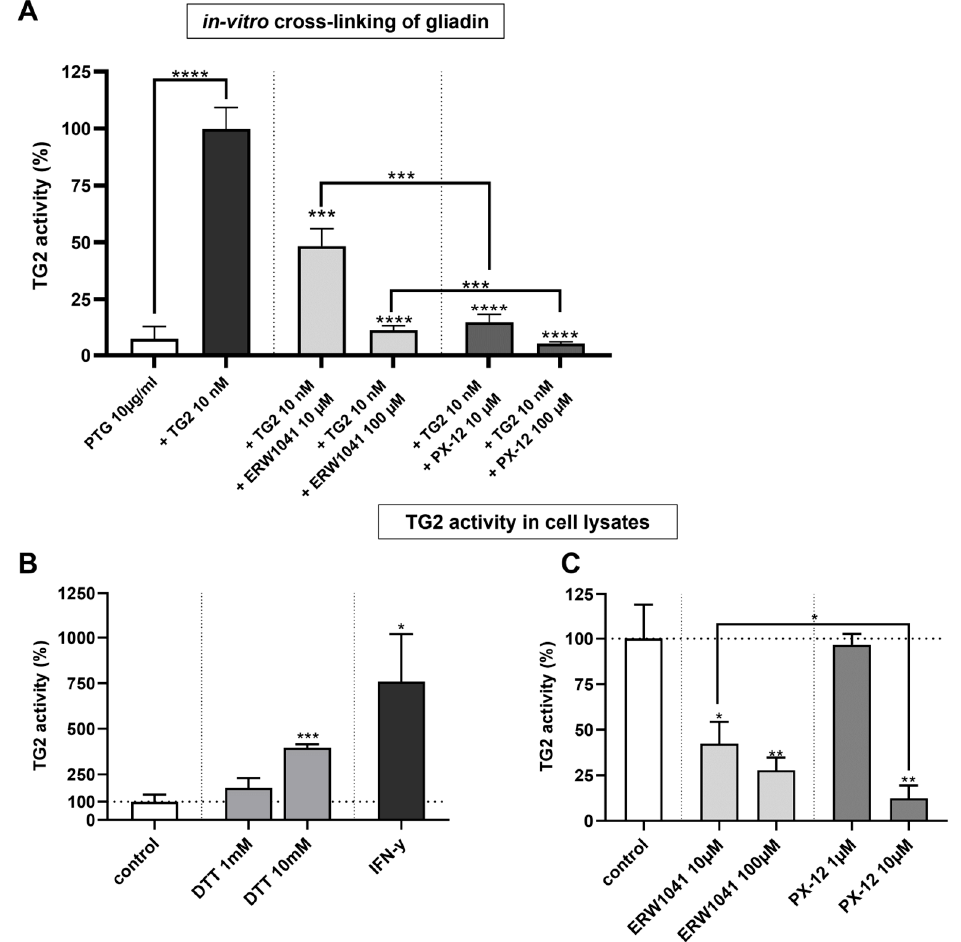
Figure 1. PX-12 inhibits recombinant and cellular TG2 more effectively than ERW1041. ( A ) TG2- mediated cross-linking of PTG was quantified by fluorometry. Normalization was performed against a condition, where the plate was coated with TG2 and no inhibitors were used. Background subtraction was performed against conditions where neither PTG nor TG2 were applied. n = 4 with three technical replicates per experiment. ( B ) TG2 activity in Caco-2 cell lysates was determined by cross-linking of 5BP (1 h). Reduction of protein lysate by DTT or treatment of Caco-2 cells with IFN- γ for 48 h significantly increased TG2 activity. Background subtraction was performed against con- ditions where no protein lysate was applied. n = 3 with three technical replicates per